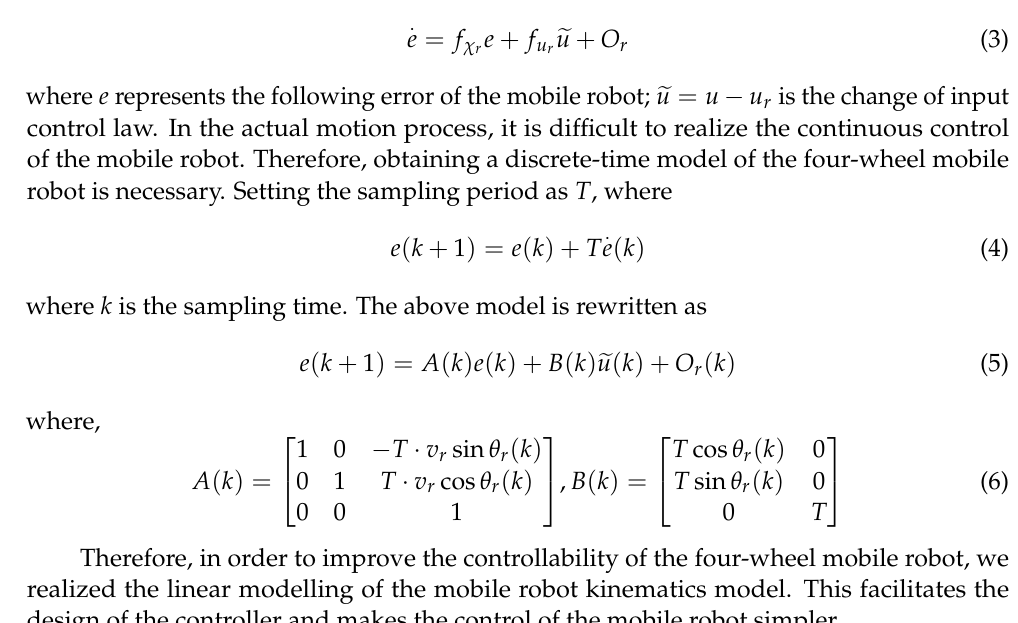
where χ r is the reference control input; u r denotes the calculated reference input, f χ and are coefficient matrices of function f ( · ) expanded at ( χ r , u r ) ; O ( r ) is the higher order remainder of the Taylor expansion. By defining e = χ − χ r , we have